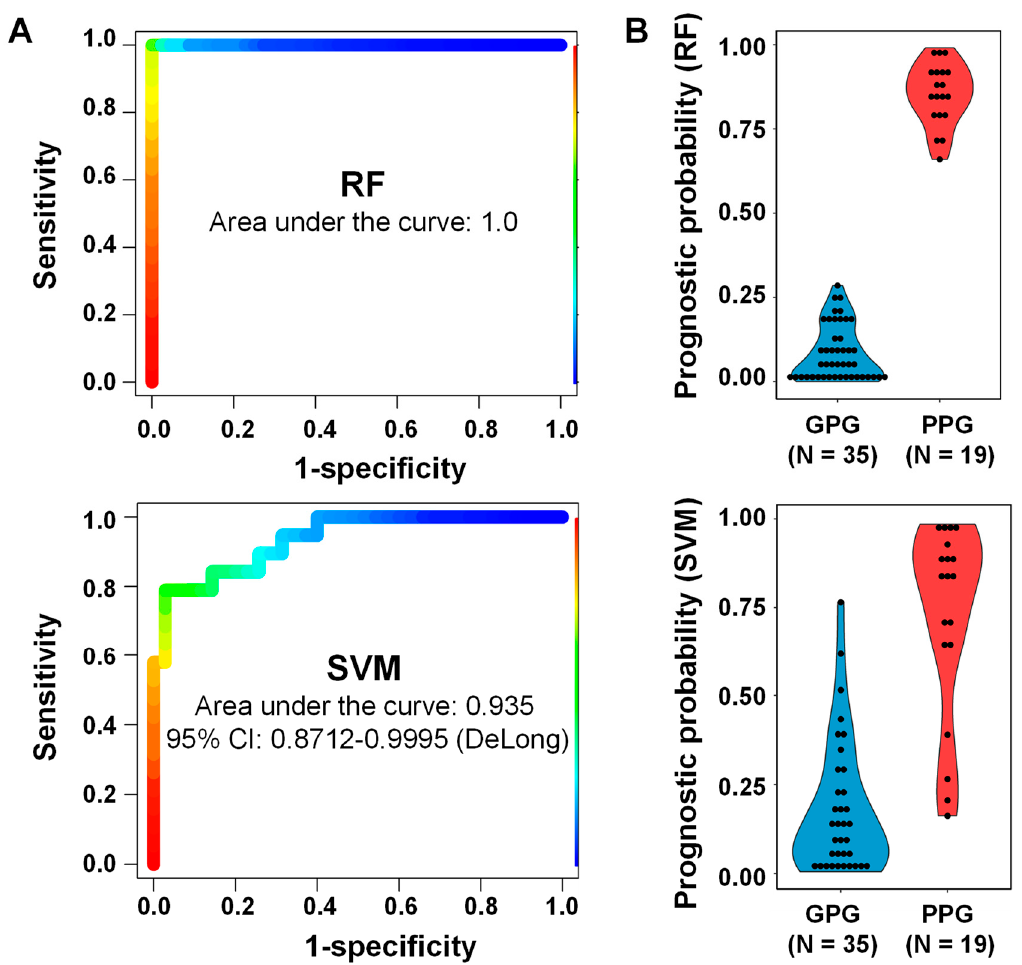
Figure 6. ROC curves of RF and SVM classifiers for five selected proteins (ACP2, CTSA, GM2A, MUC1 and SPARCL1). Performance of the two classifiers in the set of 54 samples, 35 from patients with good prognosis and 19 from patients with poor prognosis. ( A ) Areas under the curve (AUC) for the RF (1.0) and SVM (0.935) classifiers. ( B ) Clinical indices (0–1) of the two classifiers.